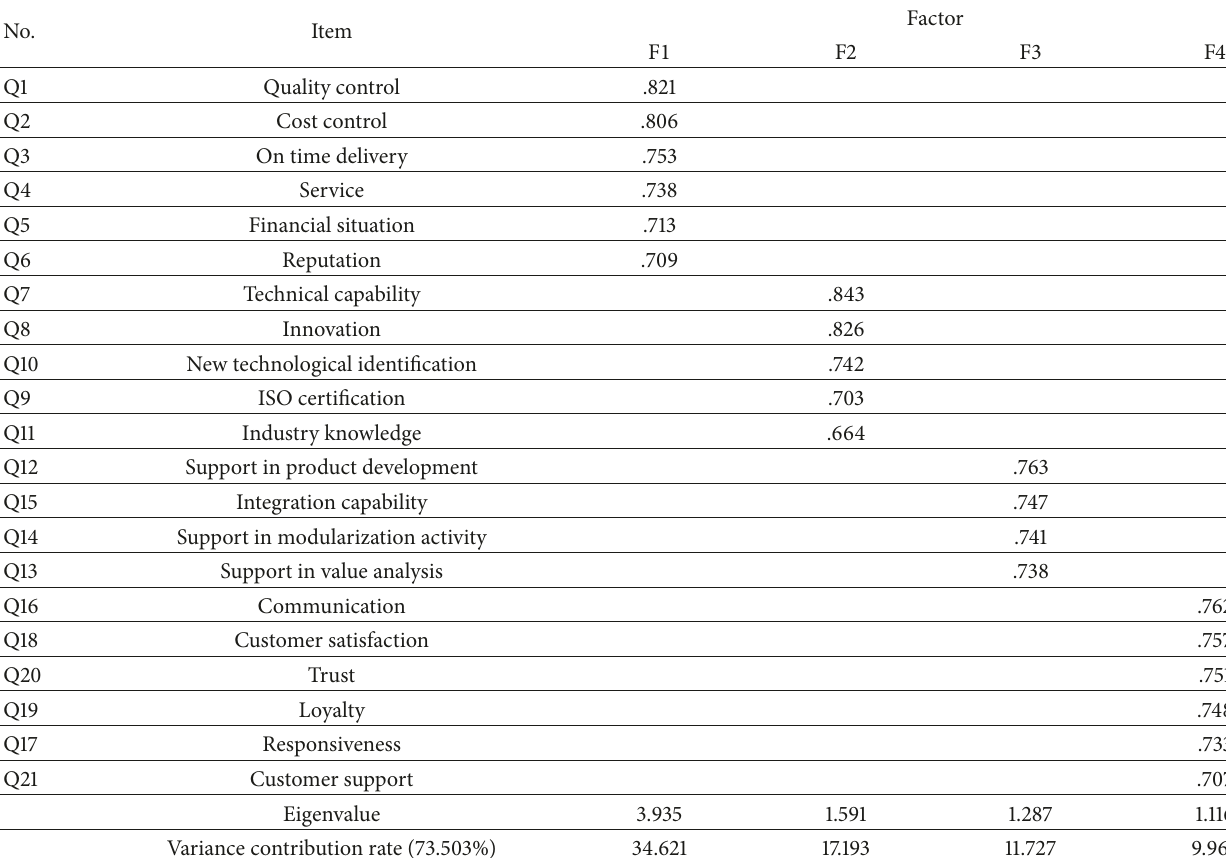
Table 6: Loadings of